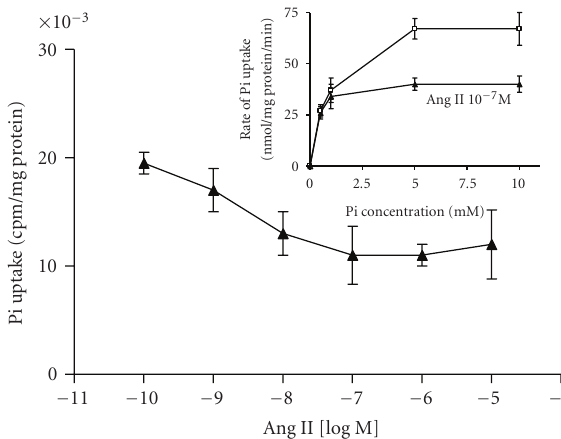
Figure 2: Inhibition of phosphate uptake in response to various concentrations of Ang II. The inset shows the e ff ect of Ang II (10 − 7 M) on phosphate uptake in the presence of various extracellular phosphate concentrations. The data are adapted from Sunga and Rabkin